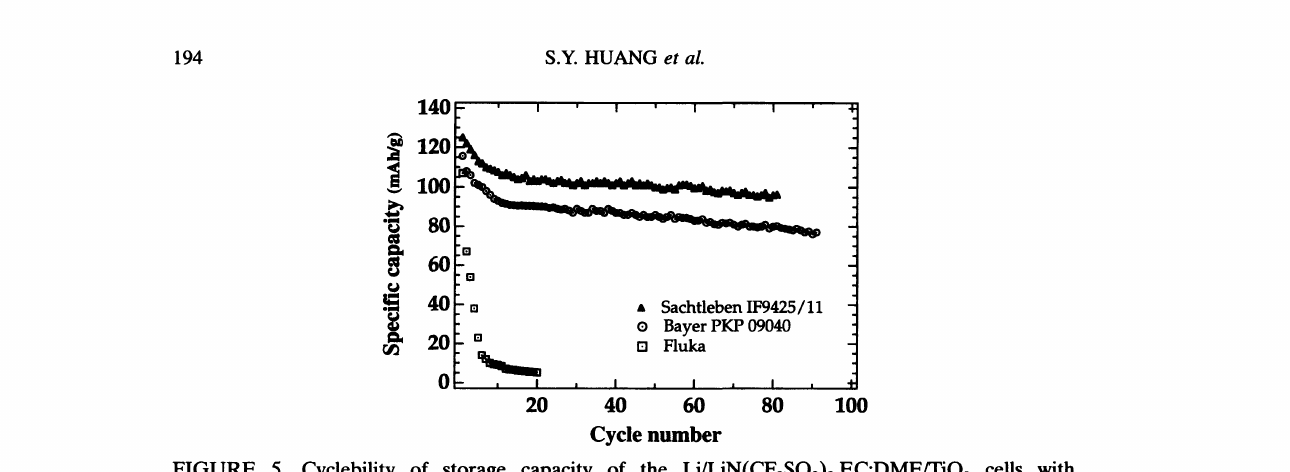
FIGURE 5 Cyclebility of storage capacity of the LULiN(CF3SO2)2,EC:DMEffiO cells th nanoscale powder (Bayer) and microscale powder (Fluka) at the relatively high cuent density of 1.32mcm 2.